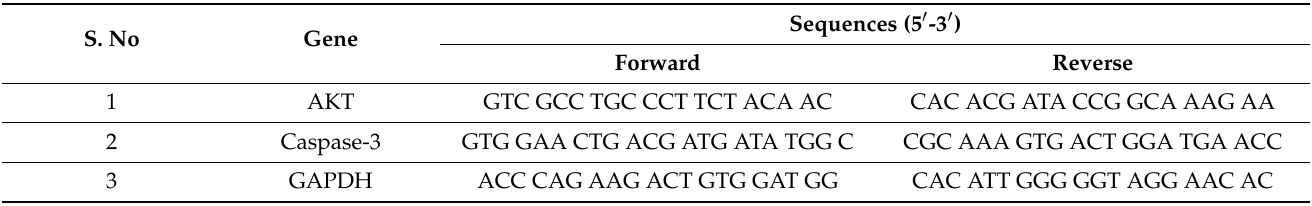
Table 1. List of primer